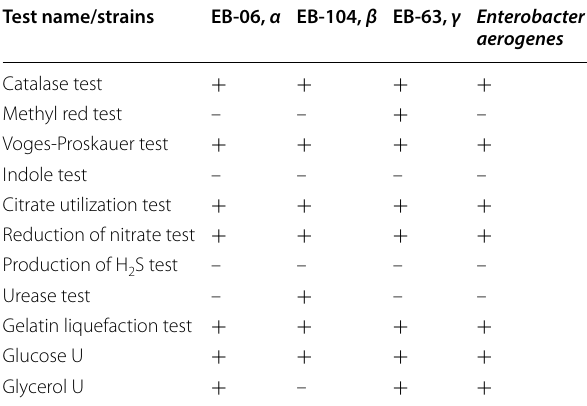
Table 2 Results of the physiological and biochemical experiment of the strains Test